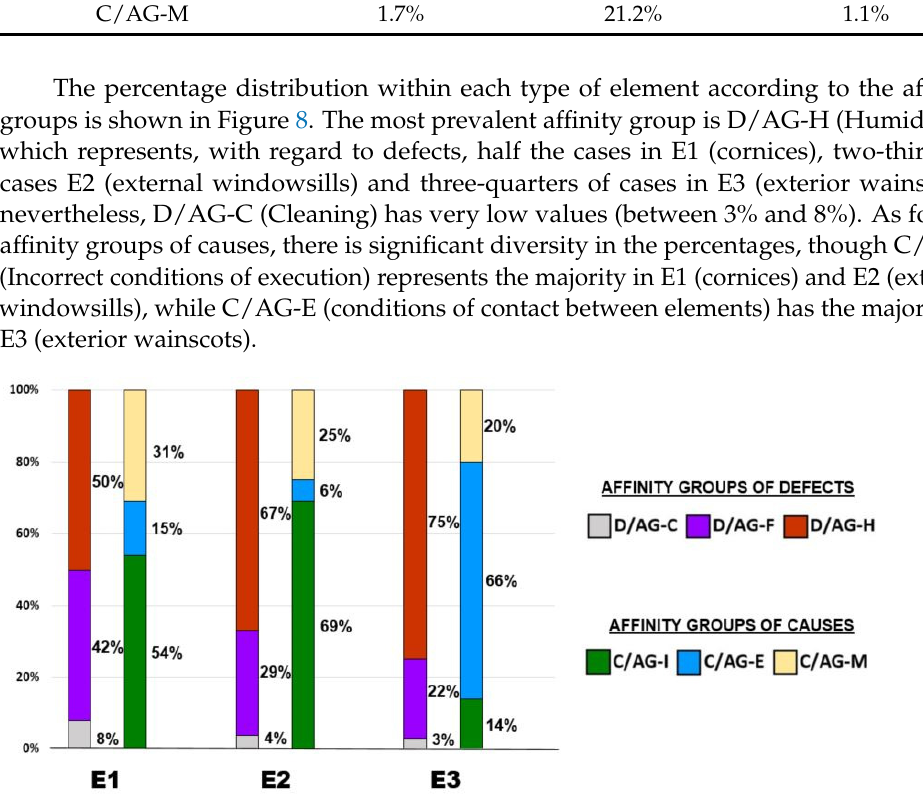
Table 3. Matrix of percentage relations between the affinity groups of defects and causes.